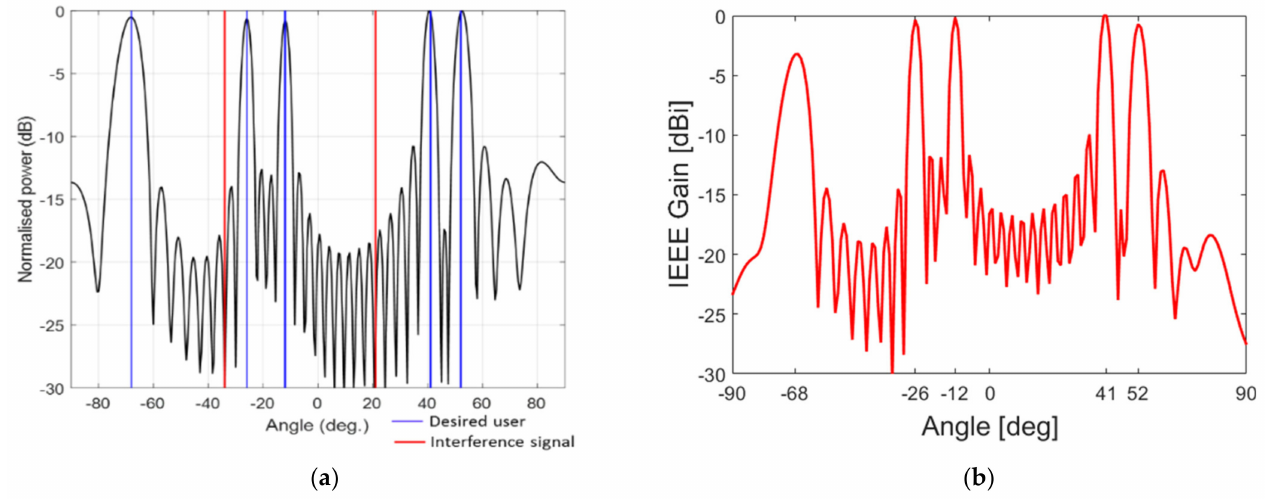
Figure 7. The performance of the proposed 2D beamforming scheme: ( a ) 2D Multi − beams simulation using MATLAB; ( b ) 2D Multi − beams simulation using CST.